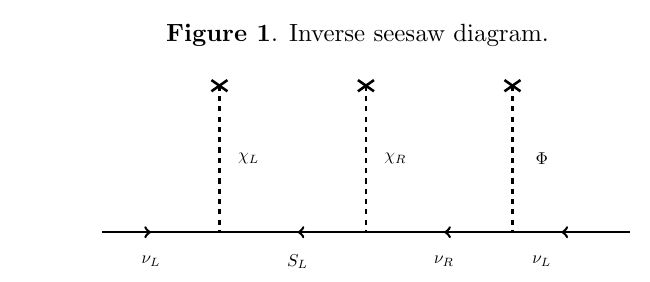
Figure 1 . Inverse seesaw diagram.